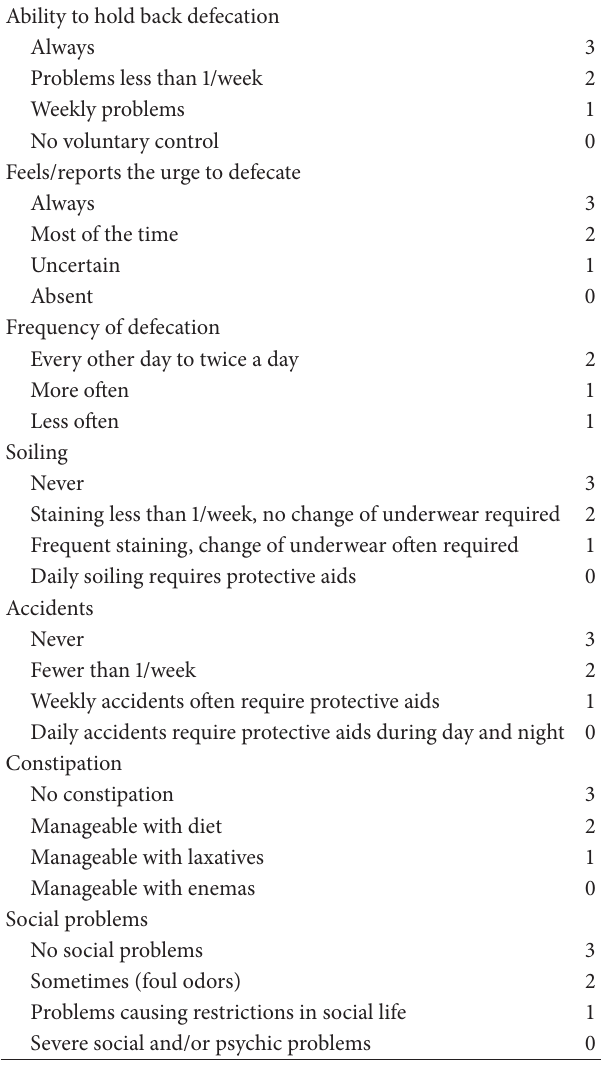
Table 1: Faecal continence scoring system (Rintala and lindahl, 1995, [10]).